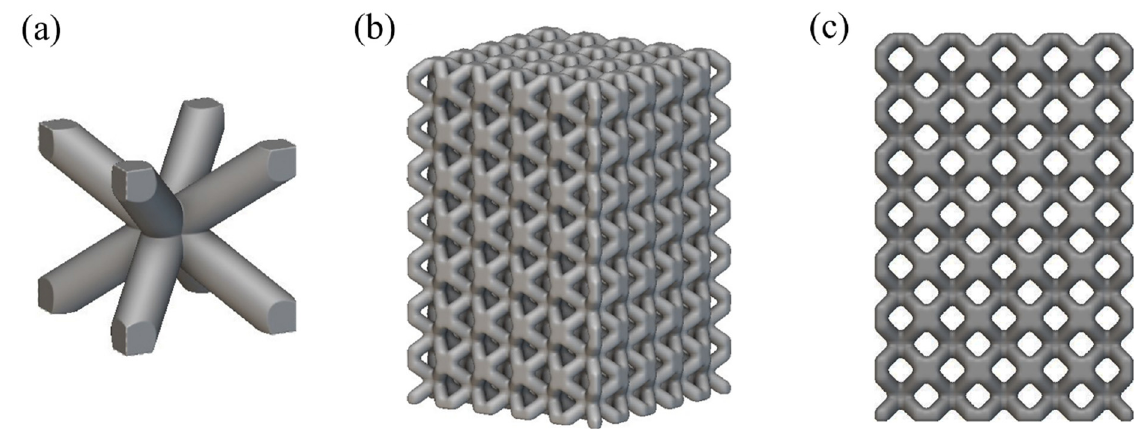
Figure 3. Lattice structure and main view of the lattice structure of the 3D-printed metallic lattice. (a)unit cell. (b)lattice structure. (c)main view of the lattice structure